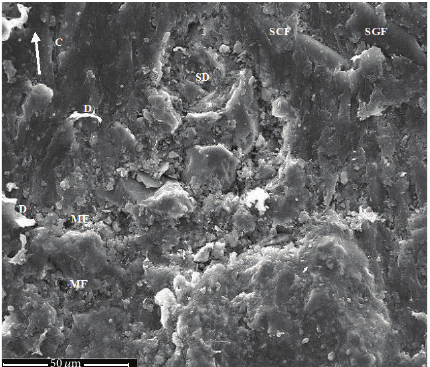
Figure 6: Scanning electron micrograph of TCE + PTFE + SGF filled with SCF, SiC and Al 2 O 3 hybrid composite abraded with sand particle size of 212 𝜇 m, to a distance of 2185 m and at a load of 40